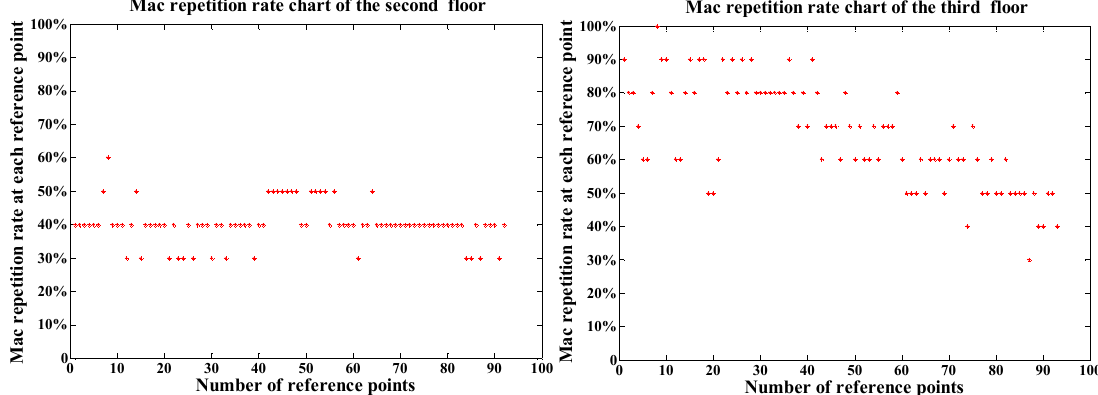
Figure 6. Comparison of MAC repetition rate chart of the second floor and that of the third one.